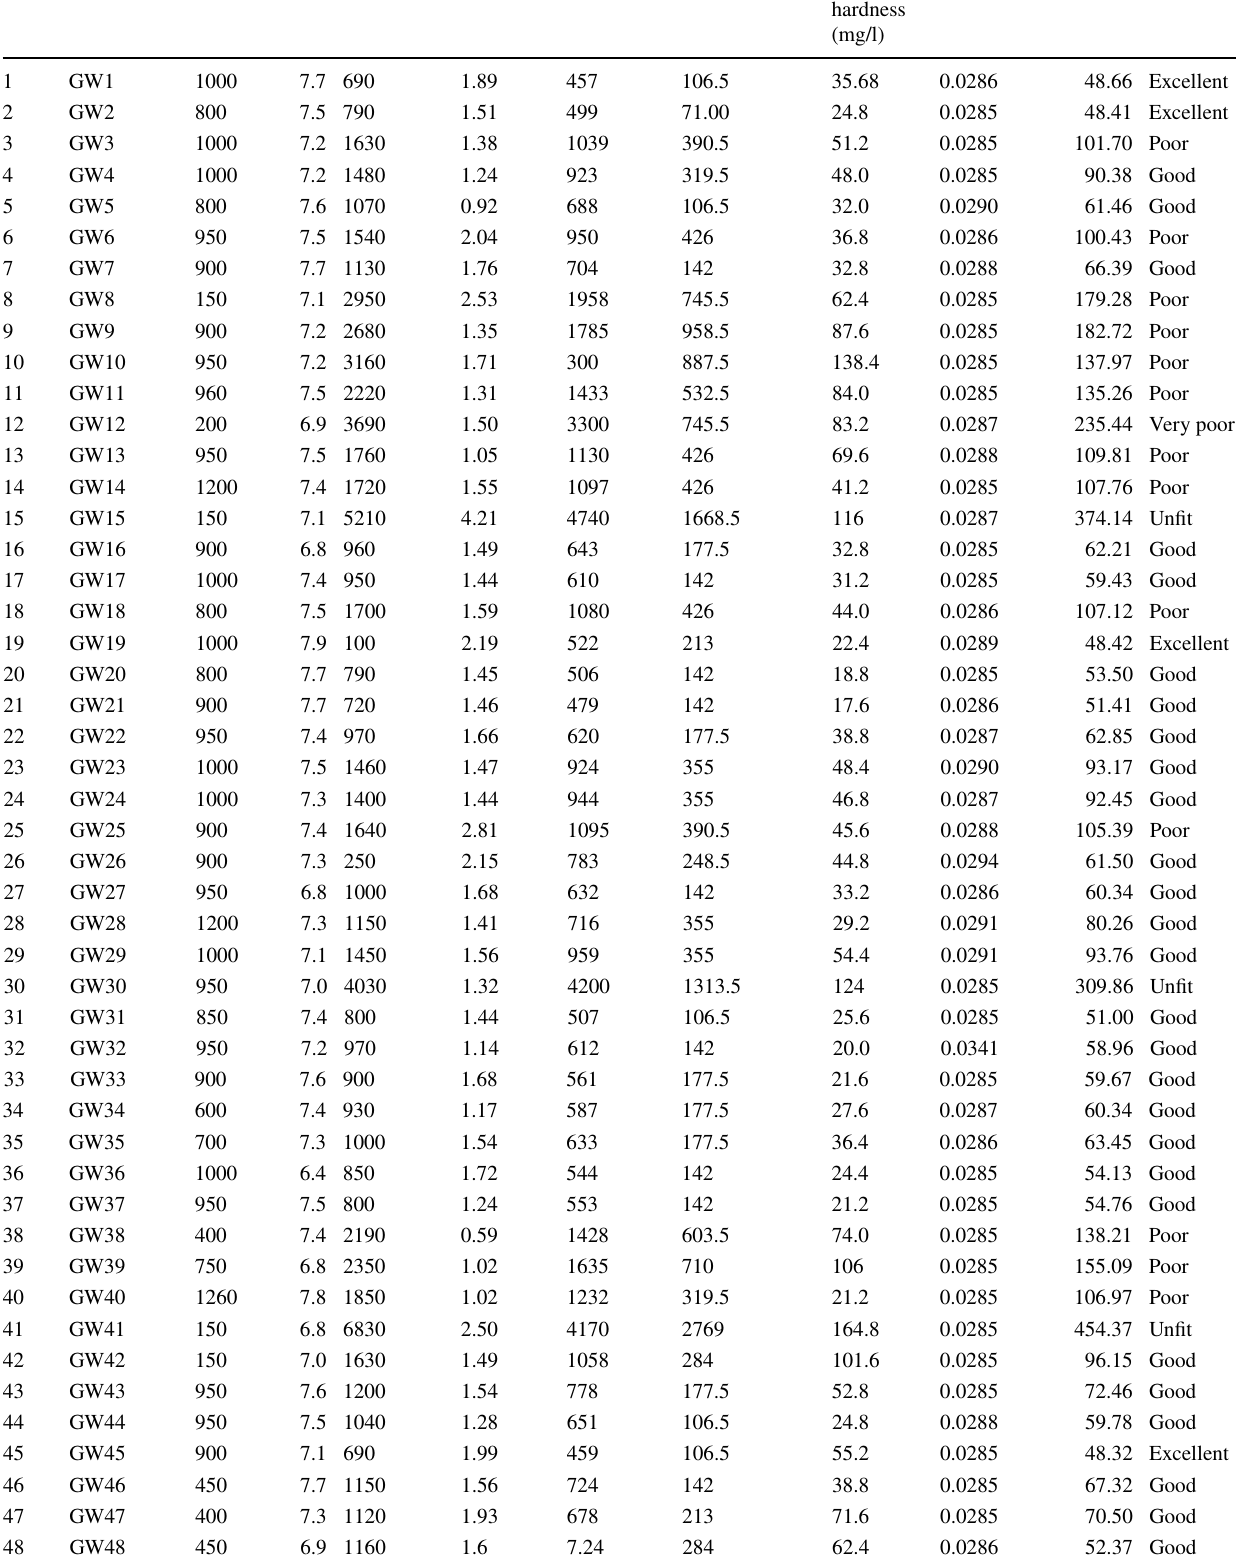
Table 4 Chemical characteristics of groundwater and WQI